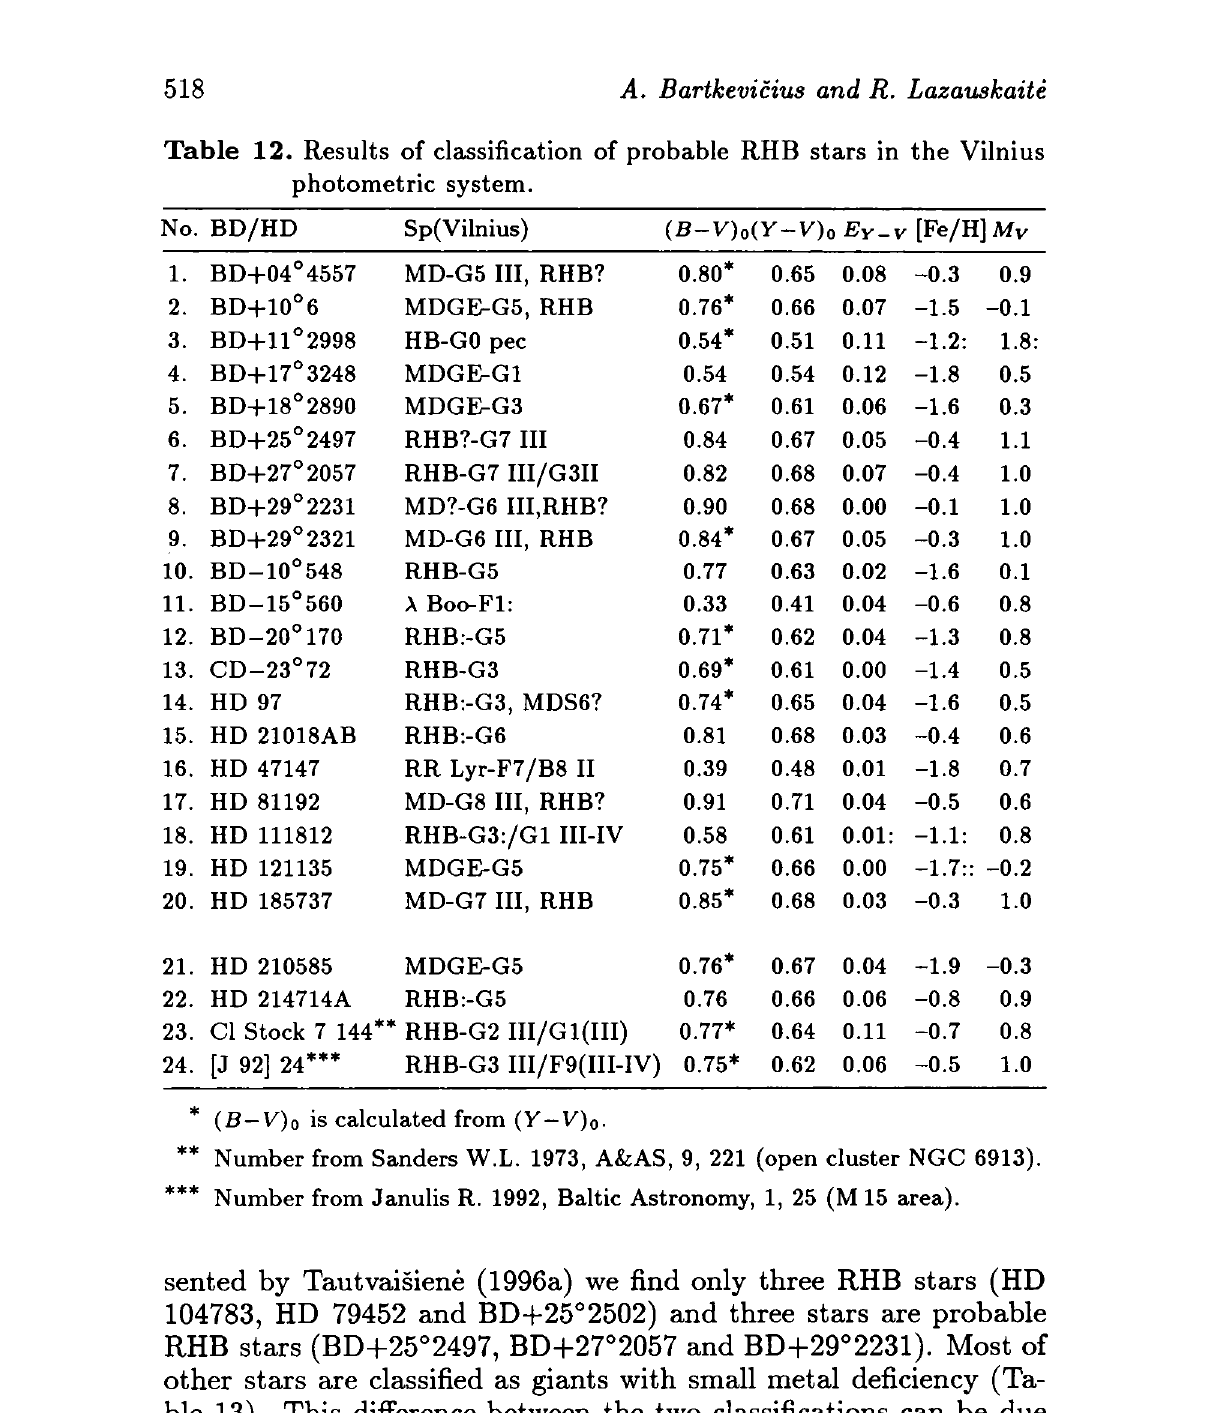
Table 12. Results of classification of probable RHB stars in the Vilnius photometric